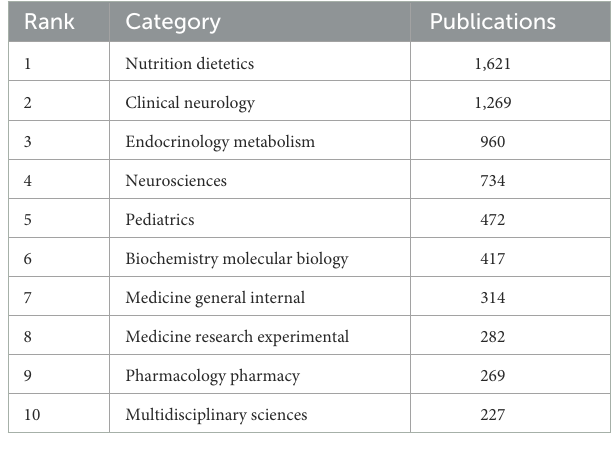
TABLE 1 The top 10 categories on LChD from 2002 to 2021.